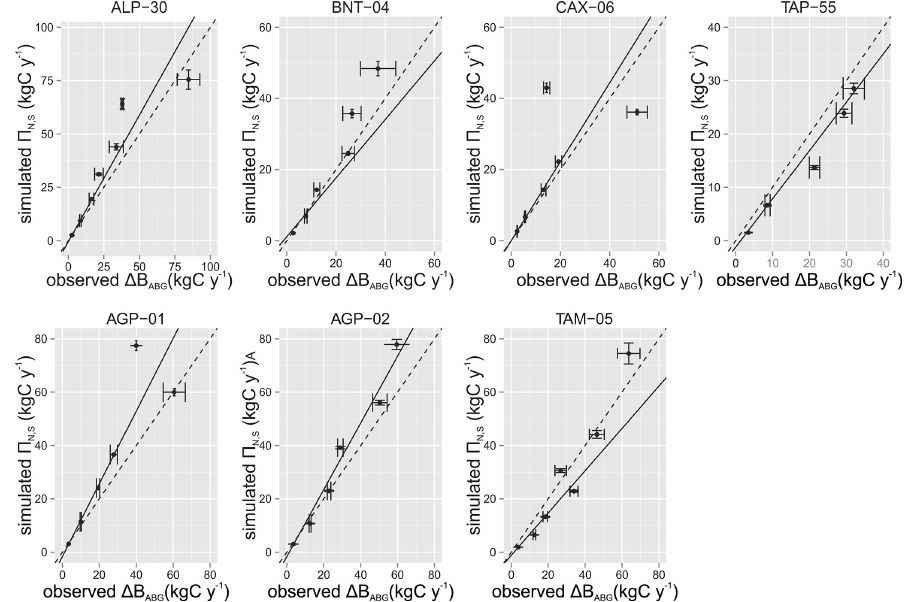
Figure 4. Simulated stem growth rate 5 N,s against observed aboveground biomass change 1B ABG for different size classes for the 2000– 2006 period. Upper panel: infertile plots. Lower panel: fertile plots. The broken line represents a 1 : 1 relationship. The continuous line illustrates the straight line fit using the York method (see text for details).